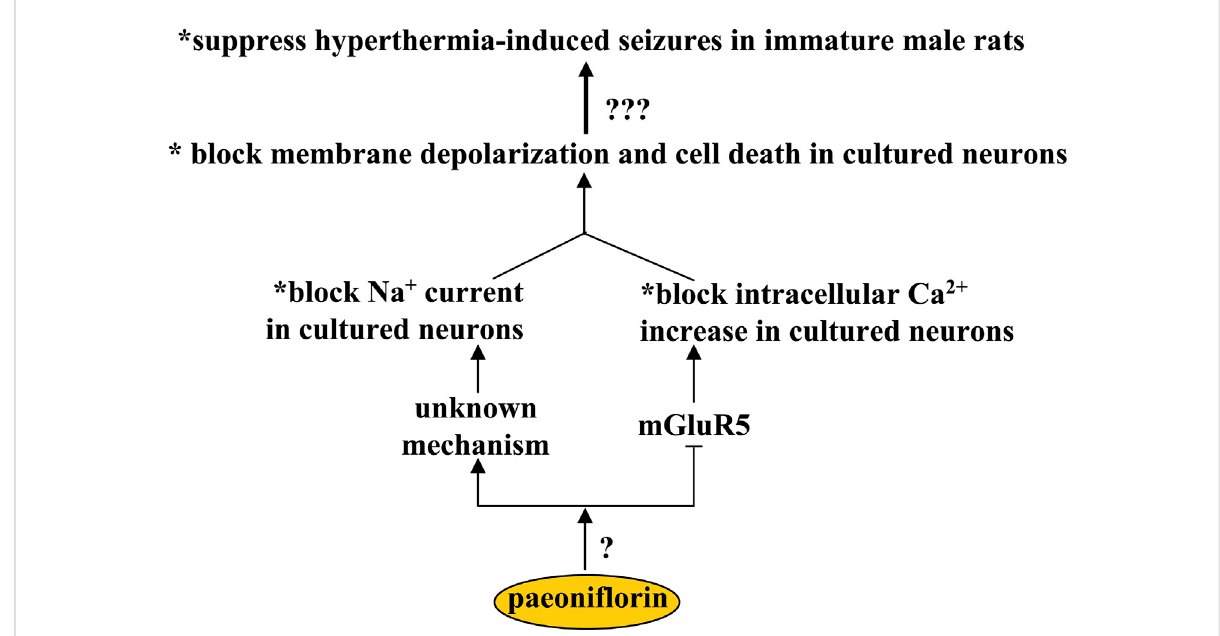
Effects andmechanismsofpaeoni fl orininepilepsy. Paeoni fl orinadministrationcansuppresshyperthermia-inducedseizures inimmaturemale rats, probably by blocking membrane depolarization and cell death in primary cultured neurons. This effect of paeoni fl orin on